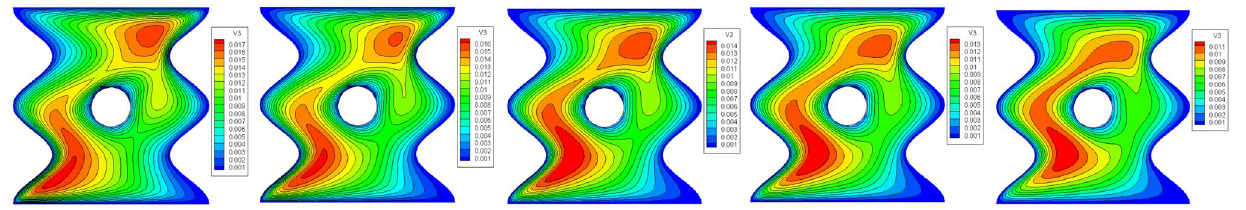
Fig. 13 Effect of the porosity (ε = {0.4, 0.5, 0.6, 0.7, 0.9}from left to right) the isotherms of fluid phase for TiO erate values; Ha = 10 , Q = 1 , Da = 10 – 3 , Ri = 1 , Gr